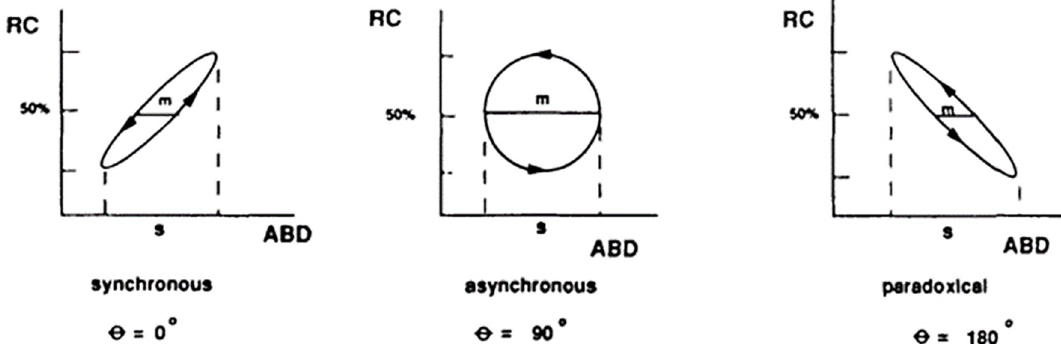
Fig 1. Chest and abdomen plots during a single breath. Reproduced from Sivan et al. [13]. Sample phase angles from chest (RC) and abdomen (ABD) data for three different single breaths: synchronous, asynchronous, and paradoxical. The variable m is the distance between the intercepts of the chest and abdomen loop with a horizontal line halfway between the minimum and maximum chest excursions, while the variable s is the maximum abdomen excursion. Phase angle is then calculated by taking the inverse sine of m/s, with the values always ranging between 0 and 180 degrees. Perfectly synchronous breathing is signified by a value of zero degrees.